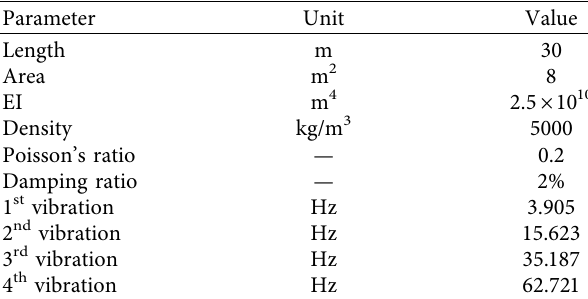
Figure 4: Verification of the BVI Table 3: Parameters of the bridge [16].